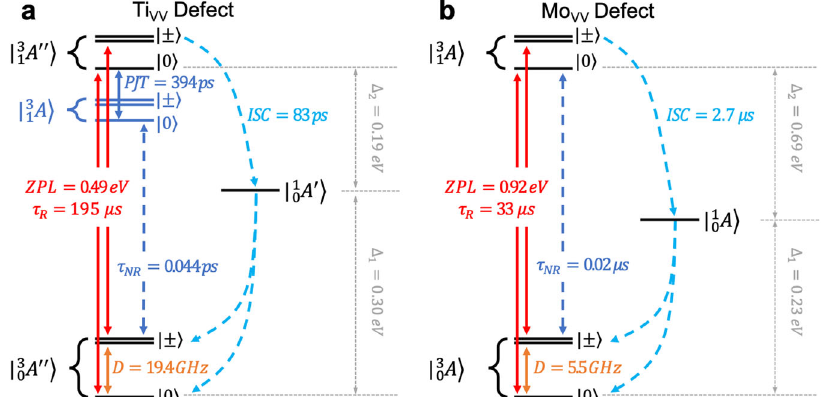
Fig. 4 Multiplet structure of triplet defects. Multiplet structure and related radiative and nonradiative recombination rates of the a Ti VV defect and the b Mo VV defect in h -BN, computed at T = 10 K. The radiative process is shown in red with zero-phonon line (ZPL) and radiative lifetime ( τ R ); the ground state nonradiative recombination ( τ NR ) is denoted with a dashed line in dark blue; and fi nally the intersystem crossing (ISC) to the singlet state from the triplet excited state is shown in light blue. The zero- fi eld splitting ( D ) is denoted by the orange line. For the Ti VV defect, the pseudo-Jahn – Teller (PJT) process is shown with a solid line in dark